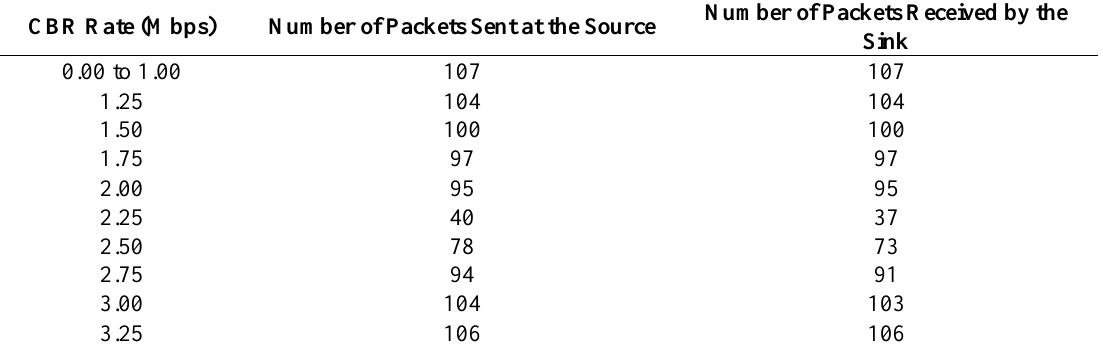
Table 6. Number of data packets received by the sink (modified AODV).